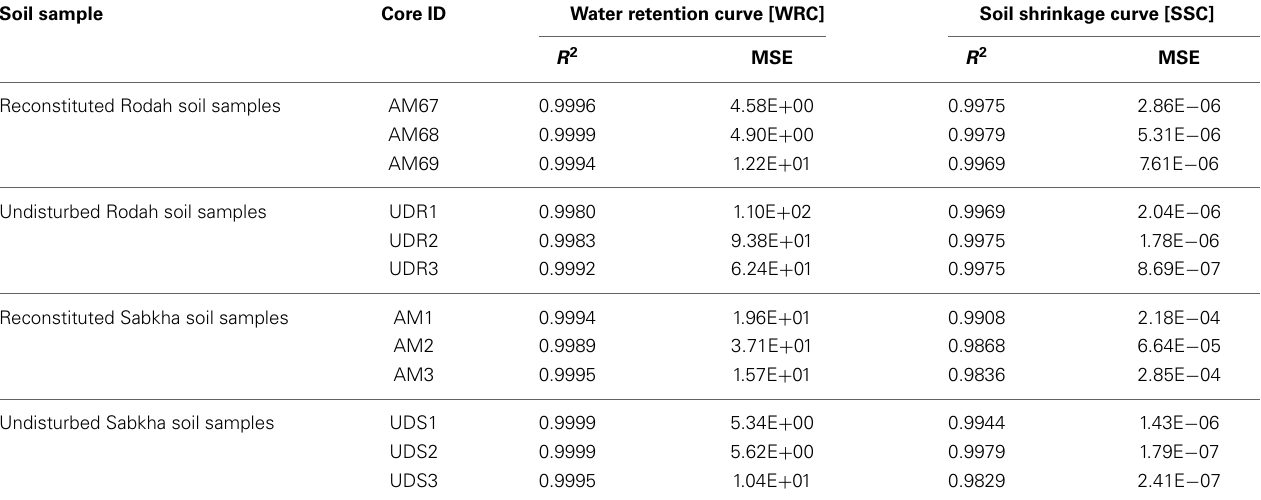
Table 5 | Statistical summary of the comparison between the measured and modeled water retention curves and soil shrinkage curves of the Rodah and Sabkha soil